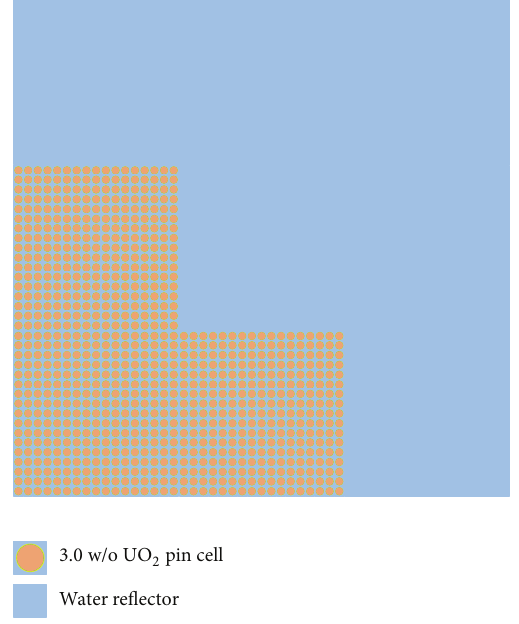
Figure 1: Plan view of 1/4 DIMPLE S06A.